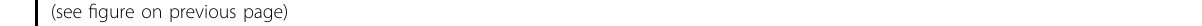
Fig. 6 MDL-800 restricts HBV in vitro and in vivo. a , b HepG2-NTCP cells were infected either with vehicle (mock) or HBV particles puri fi ed from the culture medium of HepAD38 cells, the HBV groups were treated with DMSO or MDL800, and the HBeAg ( a ) and HBsAg ( b ) level in culture medium of each group were collected and measured at indicated time points. c A Mouse model for HBV infection was established as previously described 25 . Peripheral blood samples were collected and subjected to ELISA to detect serum HBsAg, for vehicle group and MDL800 group. d Peripheral blood samples of mice treated with MDL800 or vehicle were collected and subjected to Alanine-Aminotransferase (ALT) assay. e HE or immunohistochemistry staining of liver sections from mice receiving vehicle or MD800 from experiment in F. Representative images of indicated group were shown. For the panel labeled H&E and H3K56ac, Scale bars, 200 μ m; For the panel labeled HBcAg, Scale bars, 100 μ m. f Statistics analysis of IHC results of indicated group, the mean integral optical density (IOD mean) of fi ve random visual fi elds for each sample ( n = 9 for vehicle group and n = 10 for MDL800 group) was measured. g Summary of the major fi ndings in this study. Multiomics interrogation into HBV-host interaction has led to the discovery of multiple HBV-induced DEGs including canonical and non-canonical genes in host cells. a , b Two-way ANOVA test was used, for others, student t -test was used. * P < 0.05, ** P < 0.01, *** P <